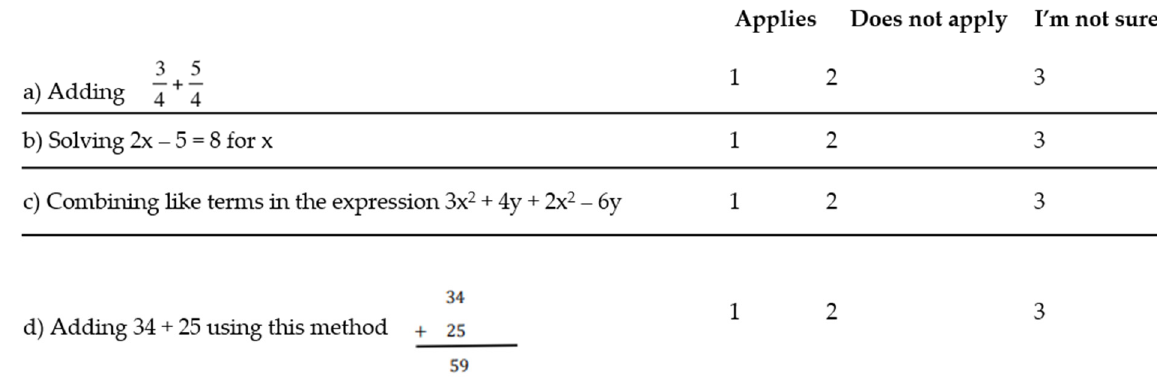
Figure 7. An example on an item on knowledge of mathematical content scale.